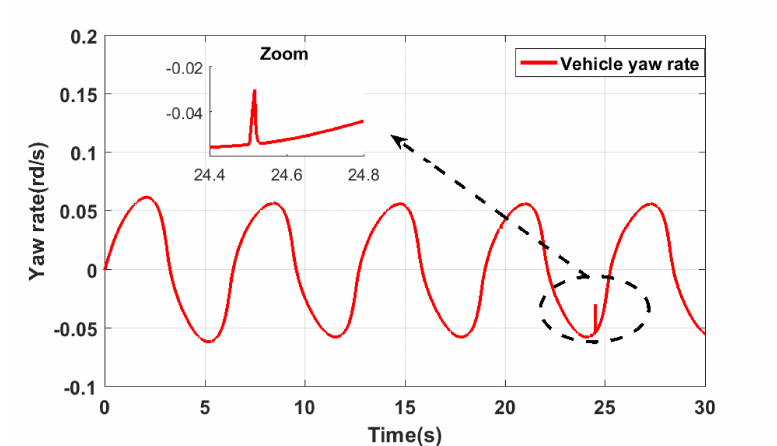
Figure 14. Fault added to the output side slip angle.